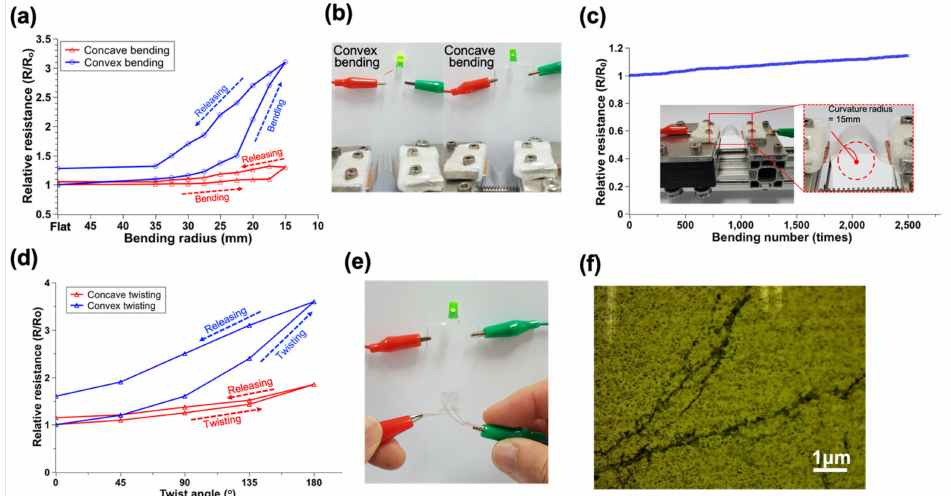
Figure 3. Electrical performance test of the meshed-type pattern on PET. ( a ) Relative resistance change with different bending radius; ( b ) image of convex and concave bending on the circuit; ( c ) relative resistance change from repeated bending with a bending radius of 15 mm; ( d ) relative resistance change with different twisting angles; ( e ) image of twisted pattern on PET, and ( f ) an optical microscope image of microscale crack after repeated bending